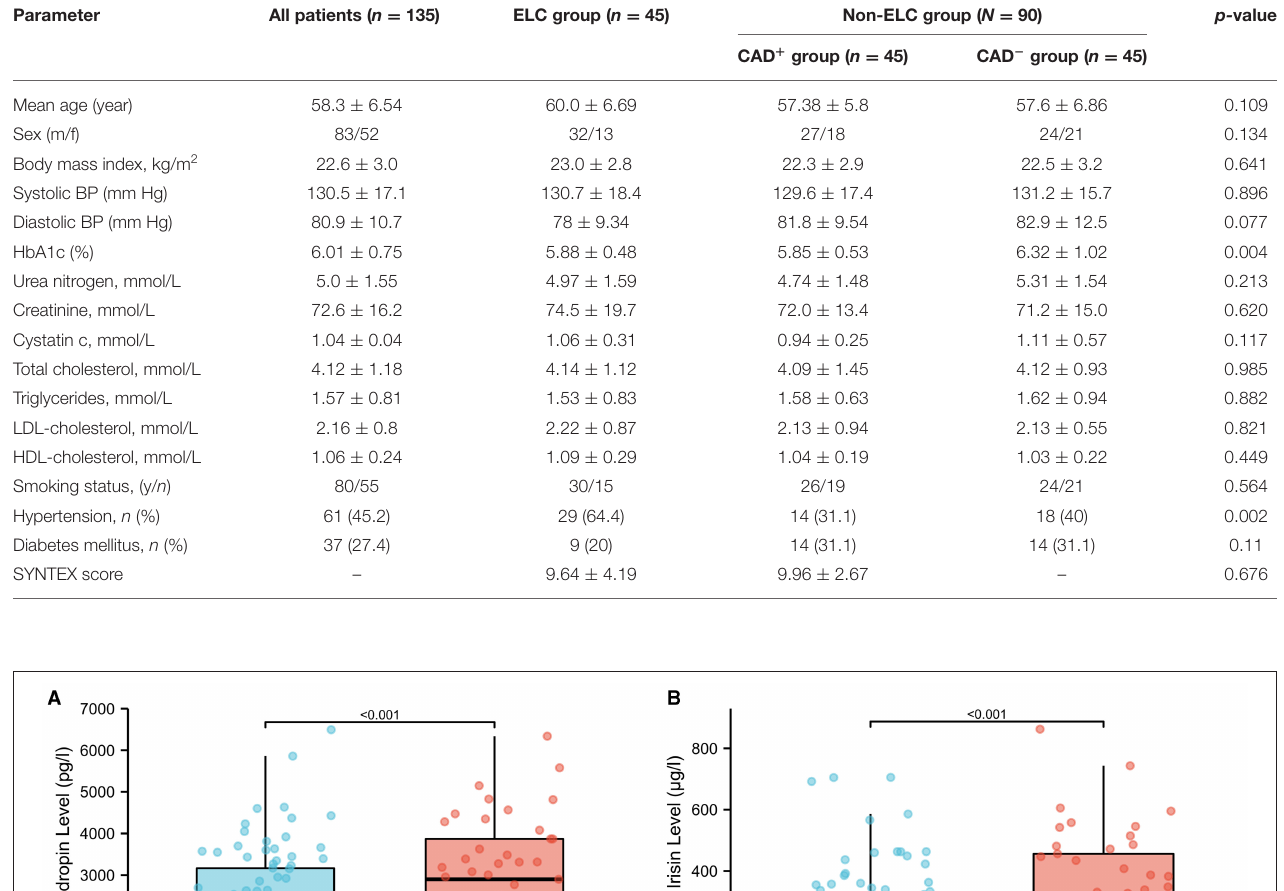
TABLE 1 | Baseline demographic and clinical characteristics of the enrolled patients. Parameter